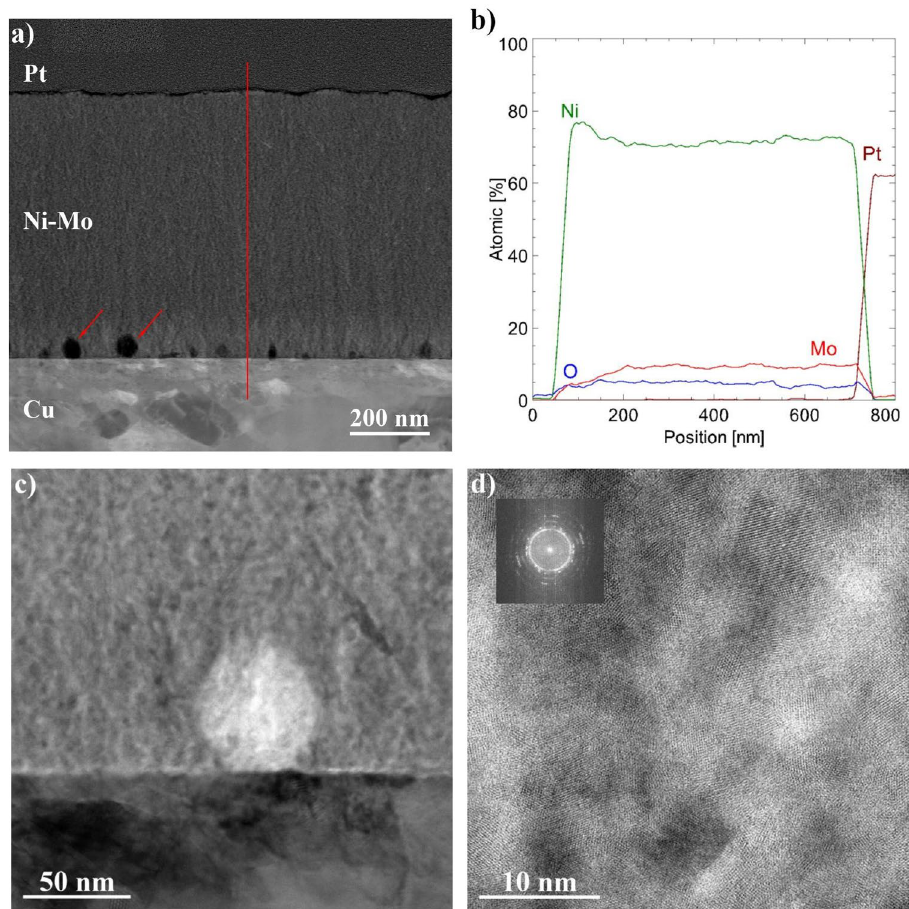
Figure 8. Cross-section of the Ni–Mo coating deposited at − 0.6 V vs. Ag for 1 h at 50 °C: STEM HAADF image ( a ) profile analysis of changes in chemical composition along the red line ( b ), STEM-BF ( c ), HR STEM-BF along with the designated FFT ( d